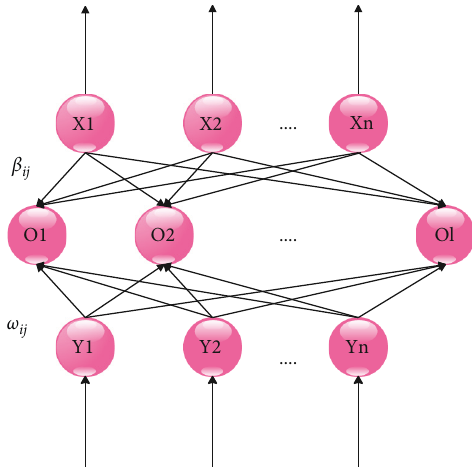
Figure 2: Feedforward neural network model.